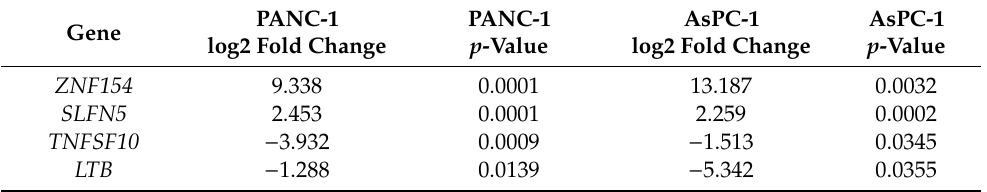
Table 4. Sequencing results in either PANC-1 or AsPC-1 cells for the genes of interest SLFN5 , TNFSF10 , LTB , and ZNF154 .